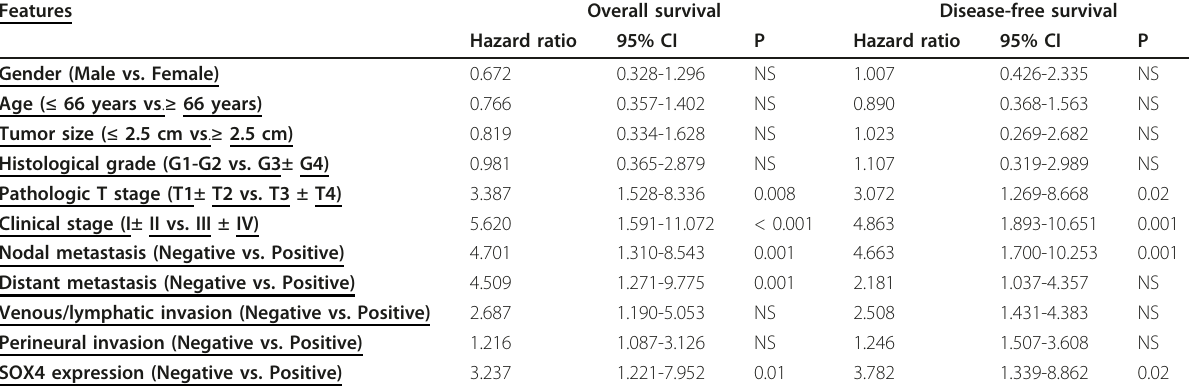
Table 2 Univariate analysis of the association between prognosis and various clinicopathologic parameters in patients with PGC